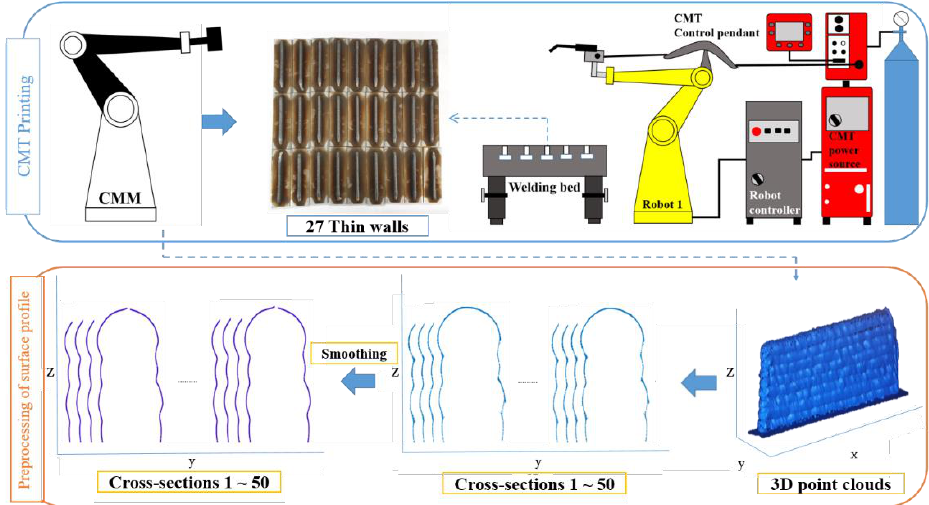
Figure 7. Pre-process and process for data collection.